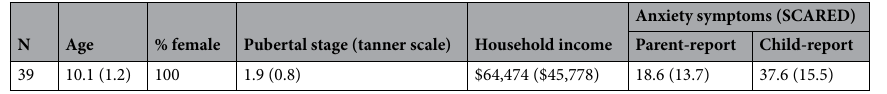
Table 1. Sample demographic characteristics and descriptive statistics for study variables. Variables are displayed as mean (standard deviation). SCARED Screen for Child Anxiety Related